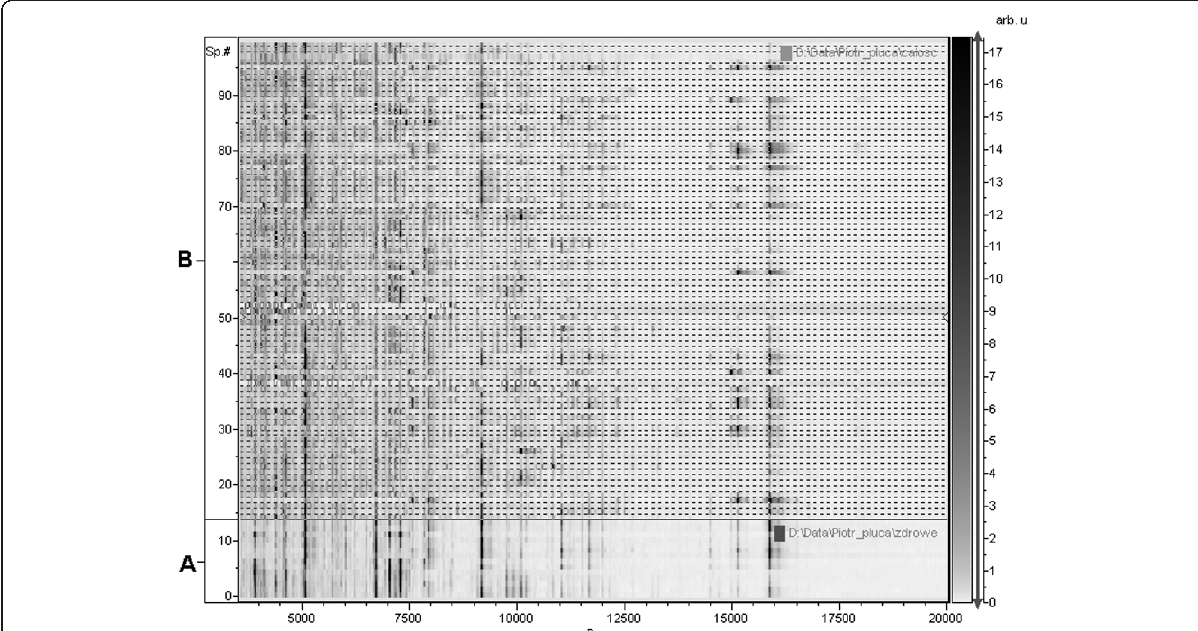
Figure 1 MS spectra in gel view mode: a) control group, b) pathologically changed tissues